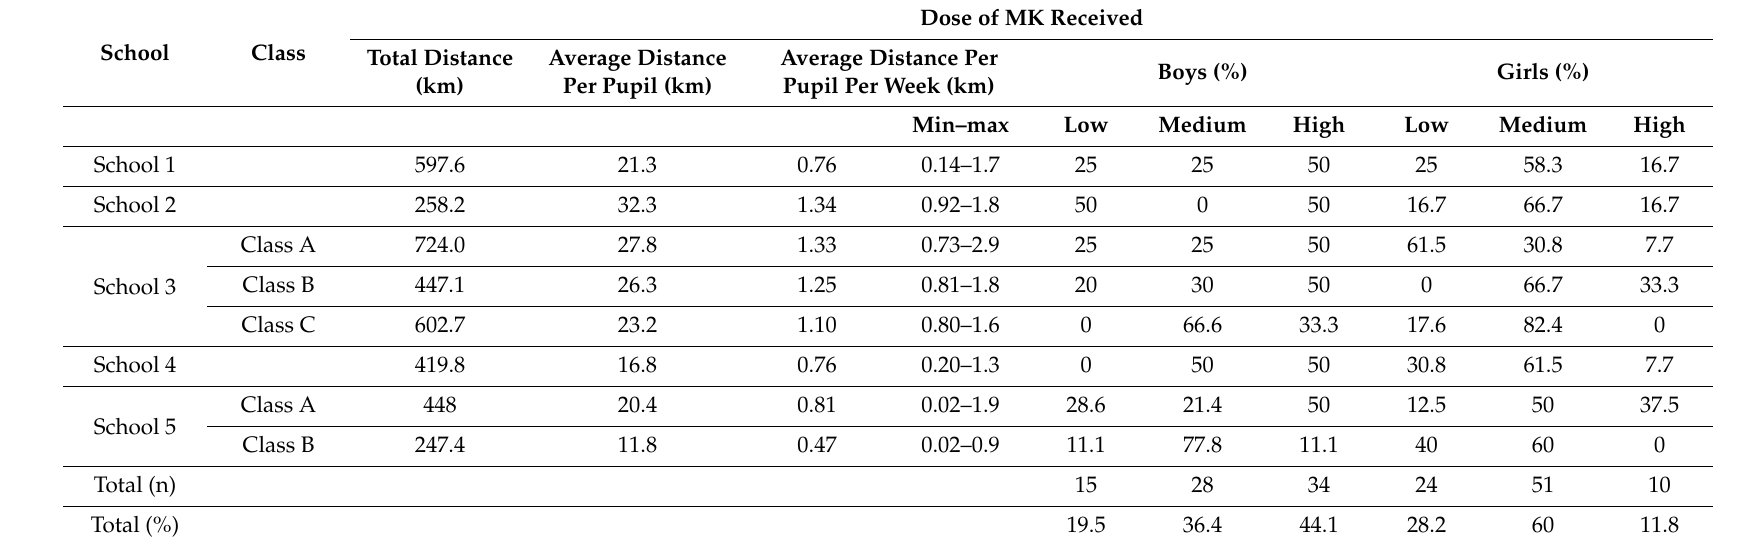
Table 6. Dose of Marathon Kids (MK) received (based on digital tracking system